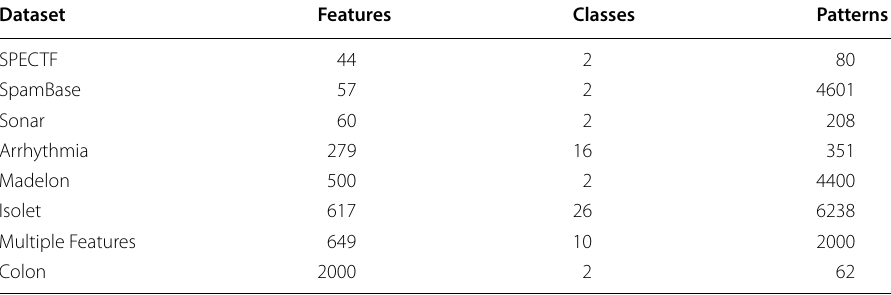
Table 1 Characteristics of the used datasets